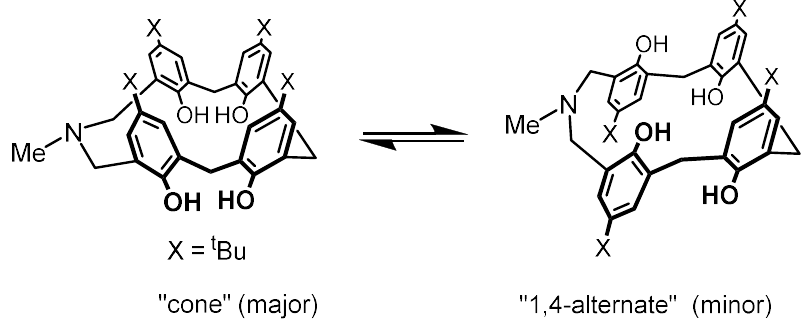
Figure 5. Conformational exchanges of N -Me-aza[3.1.1.1]arene.